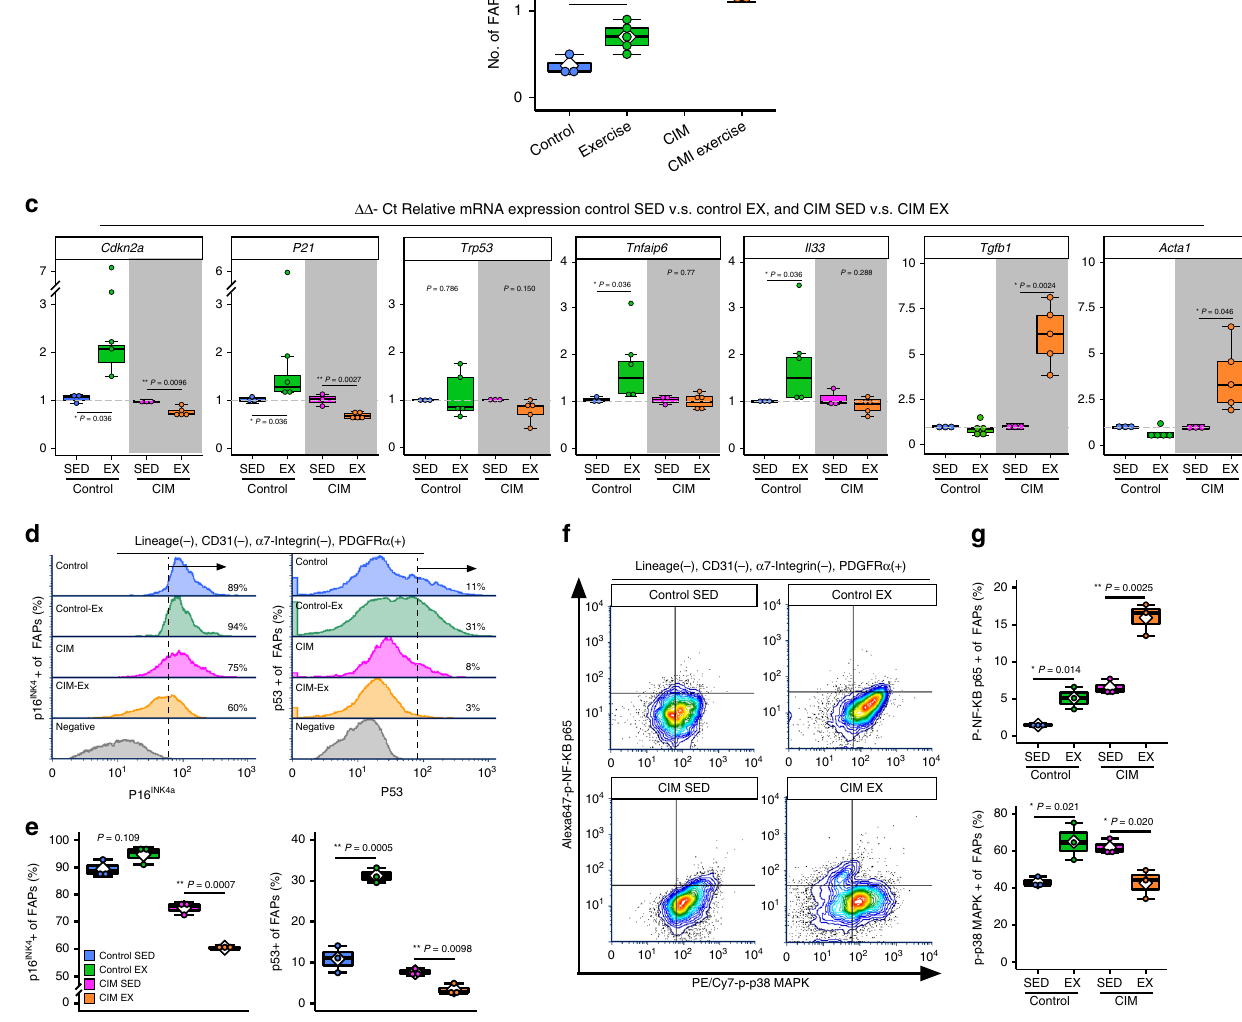
Fig. 5 Exercise-induced senescence is observed in normal mice. a Protocols for the CIM model and exercise intervention. b The number of FAPs in sedentary ( n = 3) vs. exercise control mice ( n = 5), and sedentary ( n = 5) vs. exercise CIM mice ( n = 5). c Relative mRNA expression of senescence- related genes ( Cdkn2a , Trp53 , and P21 ), pro-regenerative genes ( Tnfaip6 and Il33 ), and pro- fi brotic genes ( Tgfb1 and Acta1 ) in FAPs from sedentary control ( n = 3), exercise control ( n = 5), sedentary CIM ( n = 3), and exercise CIM ( n = 5) mice. d , g Flow cytometric analysis of p16 INK4A , p53, phospho-p38 MAPK, and phospho-p65 NF- κ B in FAPs from sedentary control, exercise control, sedentary CIM, and exercise CIM mice ( n = 3 in each group). d Representative p16 INK4A and p53 histograms from n = 3 replicates, and e quanti fi cation of the percentage of p16 INK4A + or p53 + FAPs. f Representative phospho-p38 MAPK and phospho-p65 NF- κ B contour plot from n = 3 replicates, and g quanti fi cation of the percentages of phospho-p38 MAPK + and phospho-p65 NF- κ B + FAPs. Quantitative data are shown as means as well as medians with IQRs and 1.5 times the IQR, and are displayed by dot plots and box and whisker plots. P values were determined by the two-tailed Student ’ s t test (* P < 0.05, ** P <